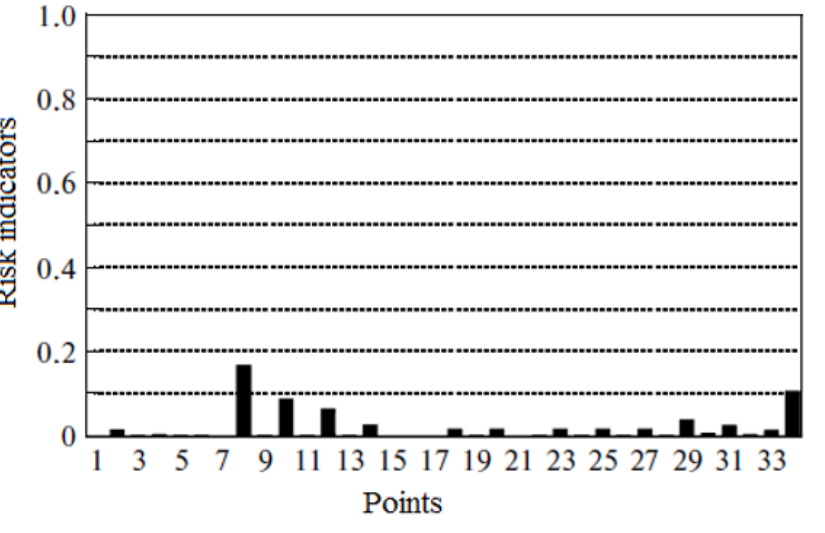
Figure 15. The diagram of risk metrics for the reconfigured power network.